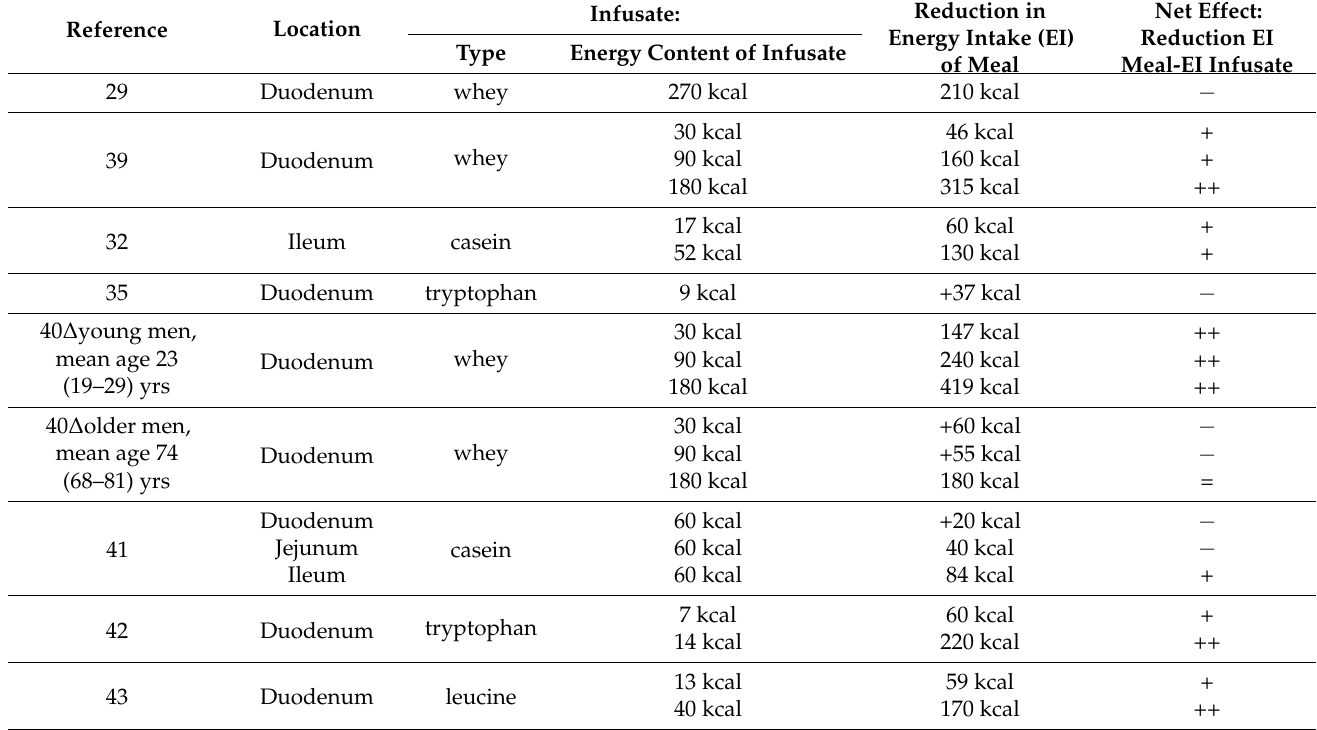
LCT: long chain triglycerides; LCFA: long chain fatty acids. − means reduction EI meal < EI infusate. = means reduction EI meal = EI infusate. +/++/+++ means reduction EI meal > EI infusate. +: 0–100 kcal; ++100–300 kcal; +++: > 300 kcal. Energy intake reduction is presented as percentage reduction of energy intake as compared to control conditions. Table A2. Net effect of infusion of proteins or amino acids into duodenum, jejunum or ileum on energy intake, taking into account the reduction in energy intake of meal minus energy content of the